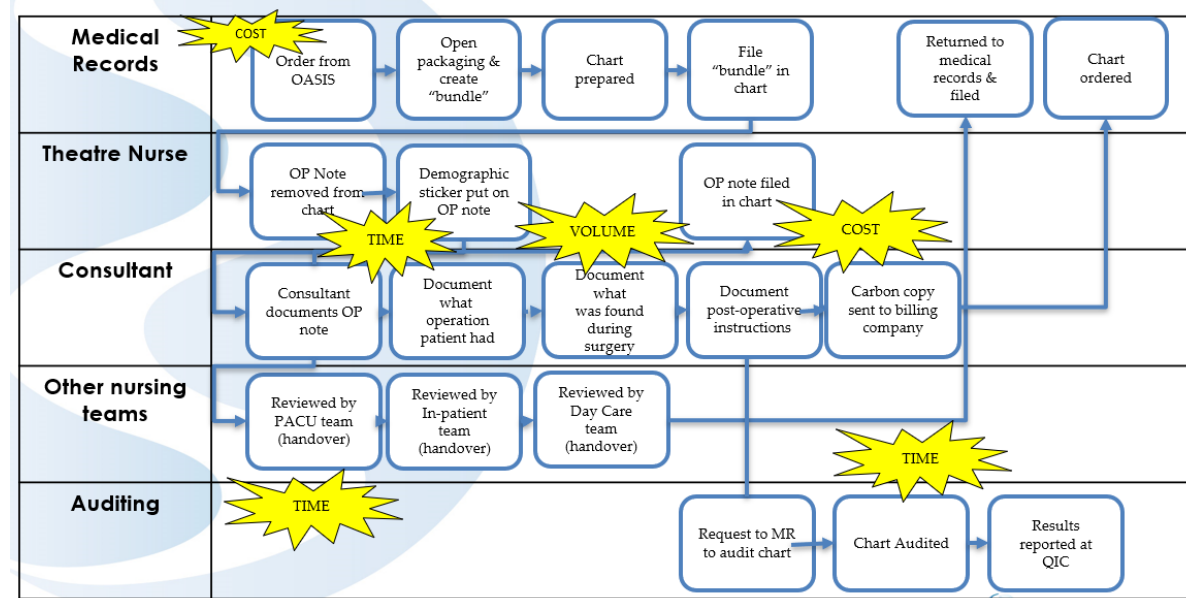
Figure 5. “ As it is” process map . Figure 5. “As it is” process